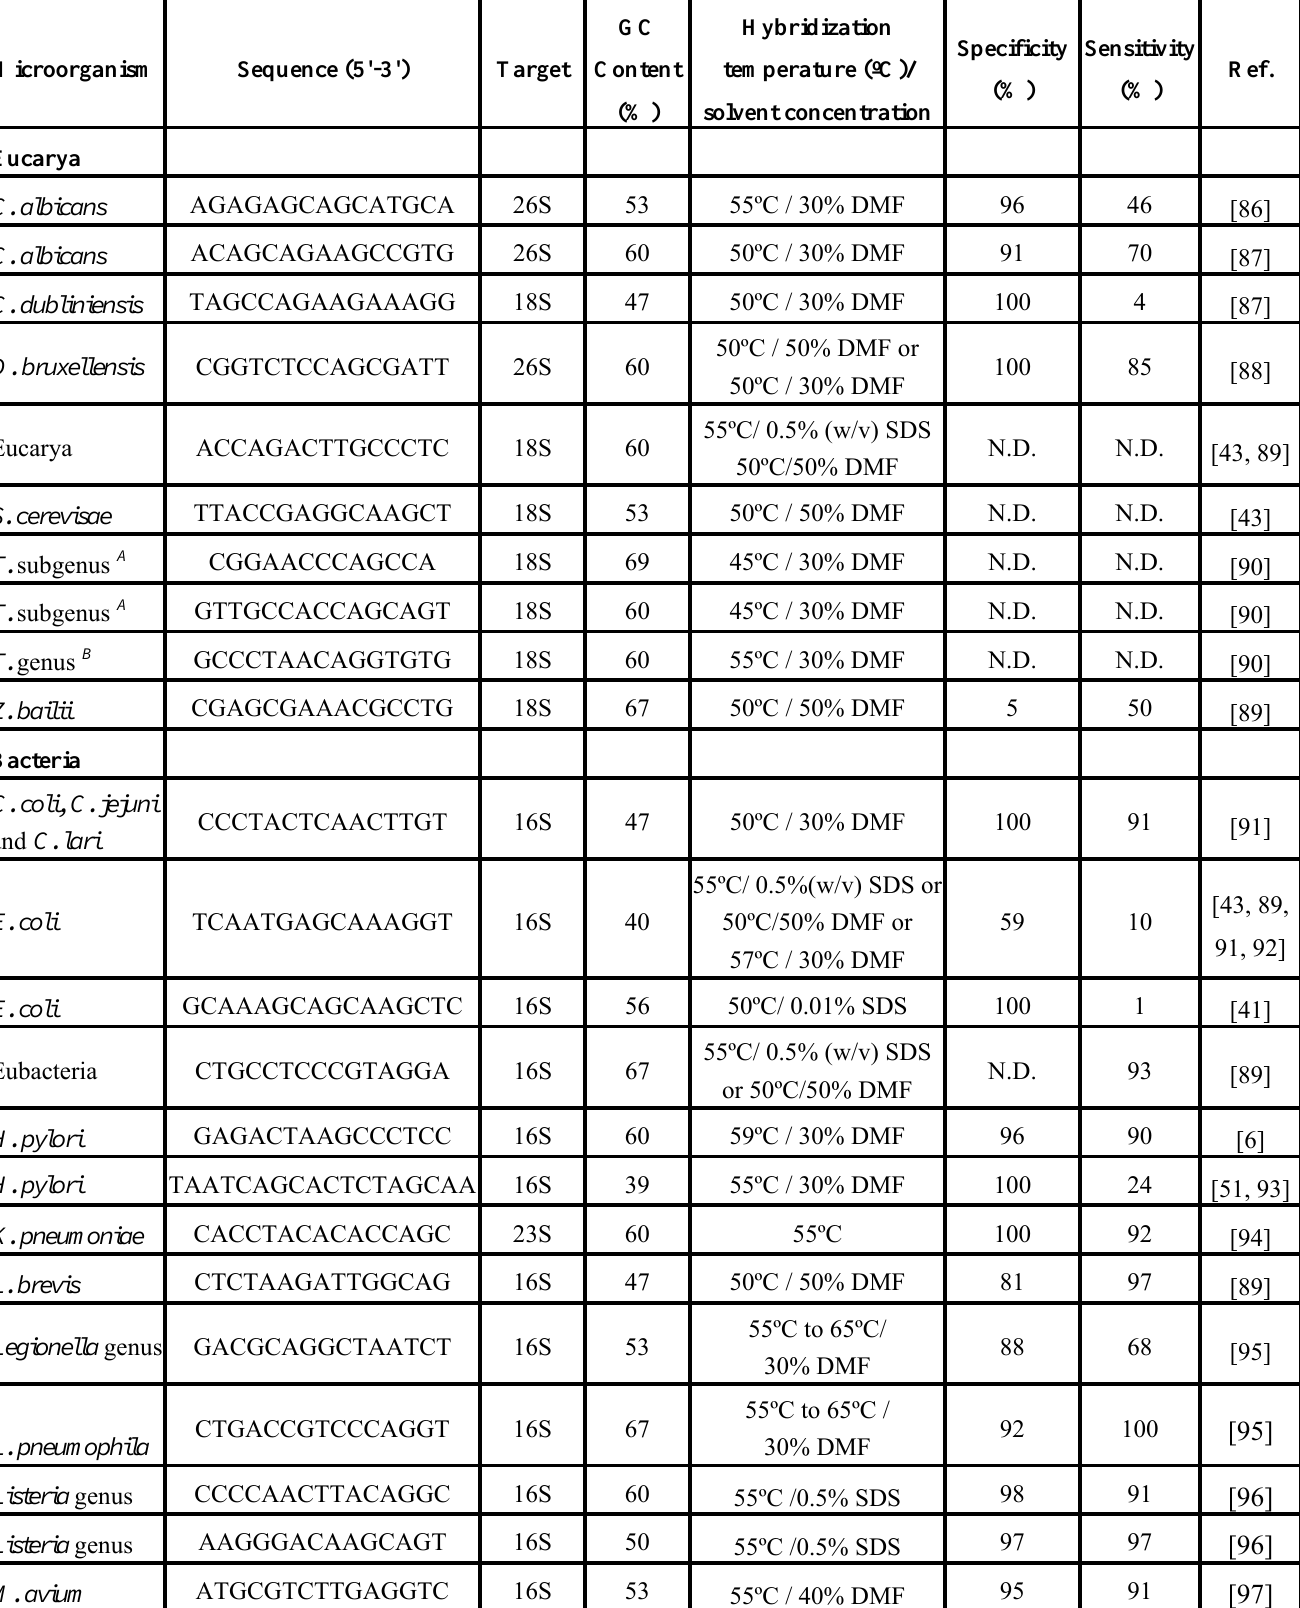
Table 1. PNA probes already described in the literature together with some of their most important